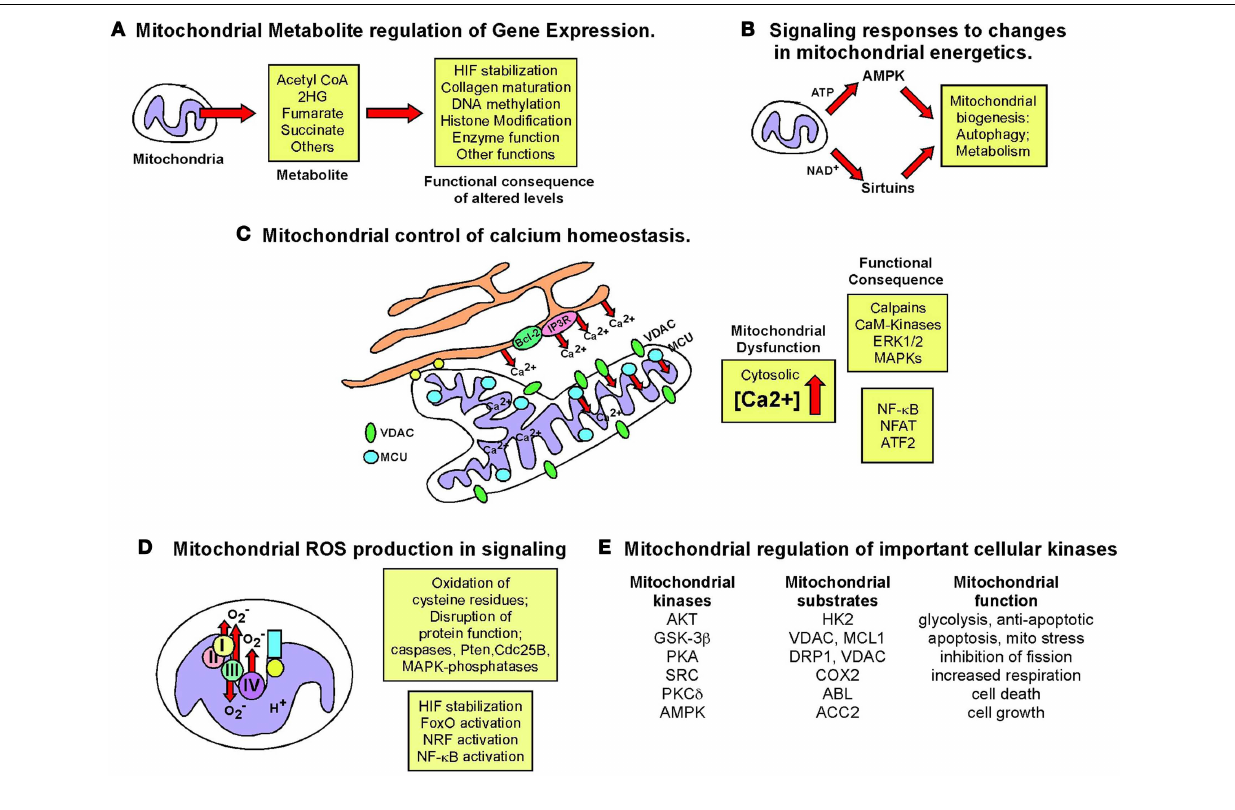
FIGURE 7 | Retrograde signaling from mitochondria to nucleus .The role of the nucleus in regulating mitochondrial function has been examined extensively but the importance of mitochondrial events in signaling to the nucleus and to other cell growth mechanisms has been relatively under-studied.The figure summarizes some key signaling consequences of dysfunctional mitochondria. (A) Mitochondrial control of nuclear gene expression through effects of altered production of certain metabolites, such as α -ketoglutarate and succinate, on epigenetic modification of histones, stabilization of key transcription factors, such as HIF, in addition to effects on other enzymes and proteins. (B) Altered production of NAD + , ATP, and other changes in mitochondrial metabolism can modulate key signaling molecules in the cell, such as AMPK and